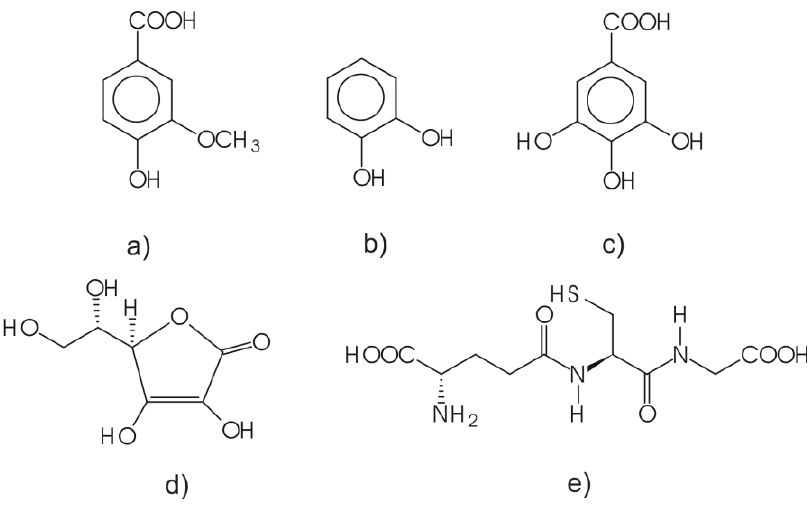
Figure 1. Chemical structure for vanillic acid (a) ; catechol (b) ; gallic acid (c) ; L -ascorbic acid (d) ; L -glutathione (e)